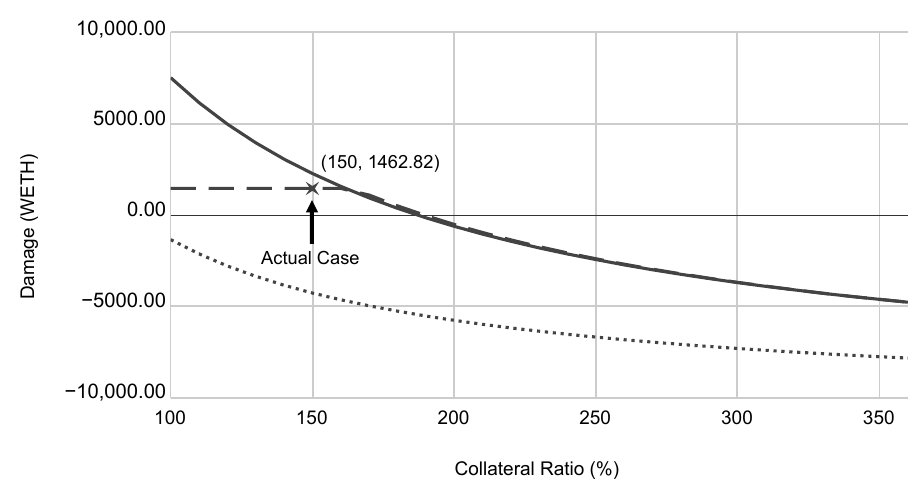
Figure 4. Dynamic collateral ratio